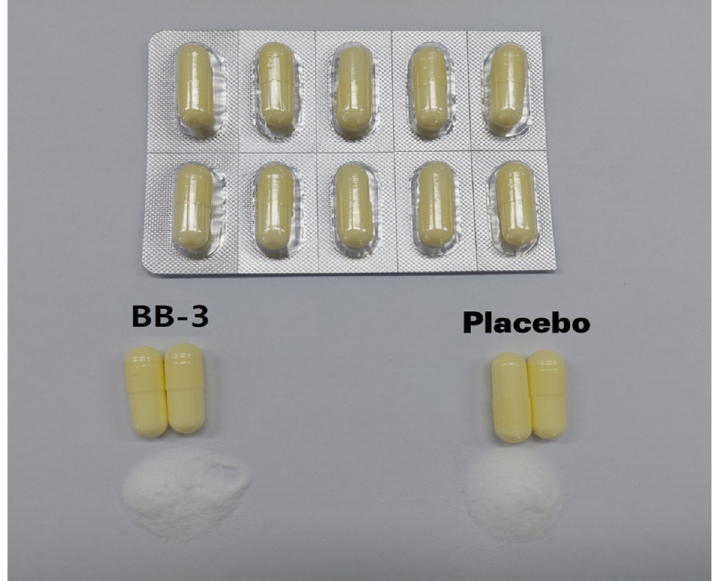
Figure 2. BB-3 and placebo capsules. BB-3: Bifidobacterium breve